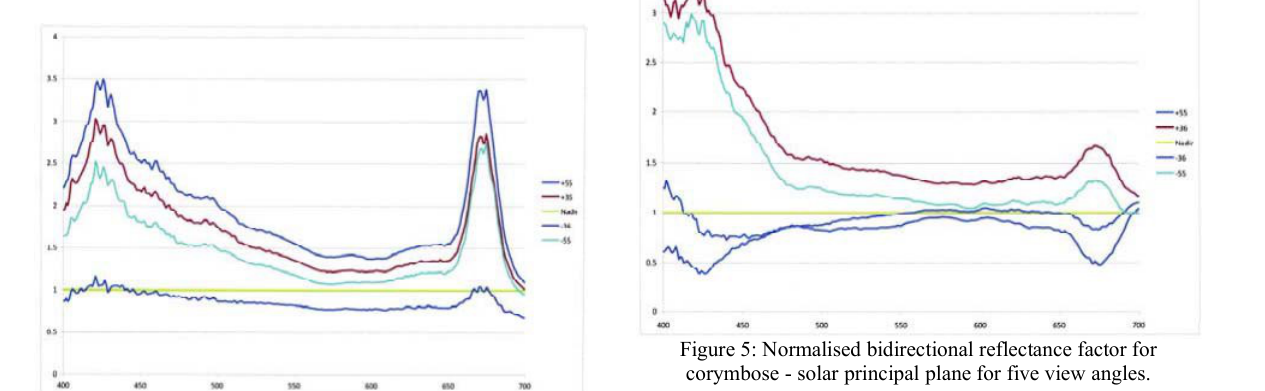
Figure 2: Reflectance of arborescent coral in the solar principal plane for five view angles.